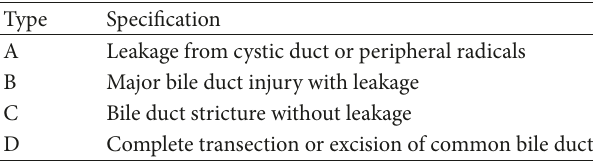
Figure 6: Percutaneous pigtail catheter drainage. Table 1: Amsterdam classification of bile duct